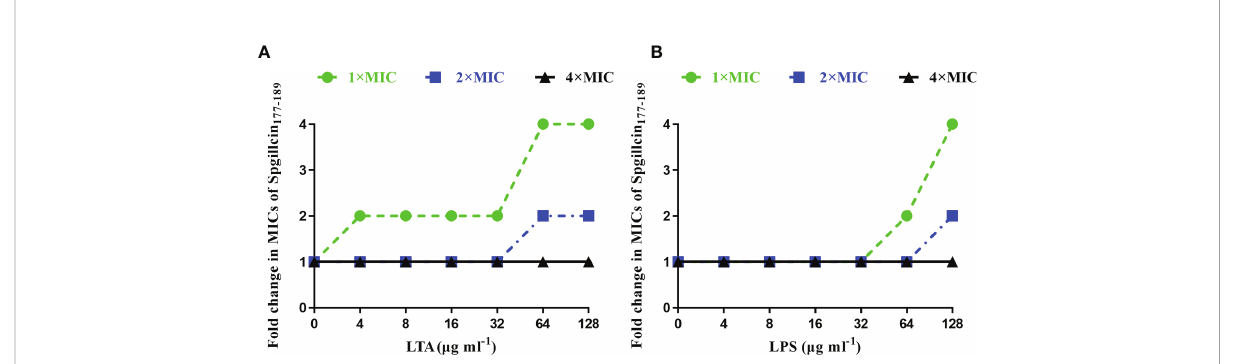
FIGURE 7 Inhibitory effect of lipoteichoic acid (LTA) and lipopolysaccharide (LPS). (A) LTA impaired the bactericidal activity of Spgillcin 177 – 189 against S. aureus in a dose-dependent manner. (B) LPS impaired the bactericidal activity of Spgillcin 177 – 189 against P . aeruginosa in a dose-dependent